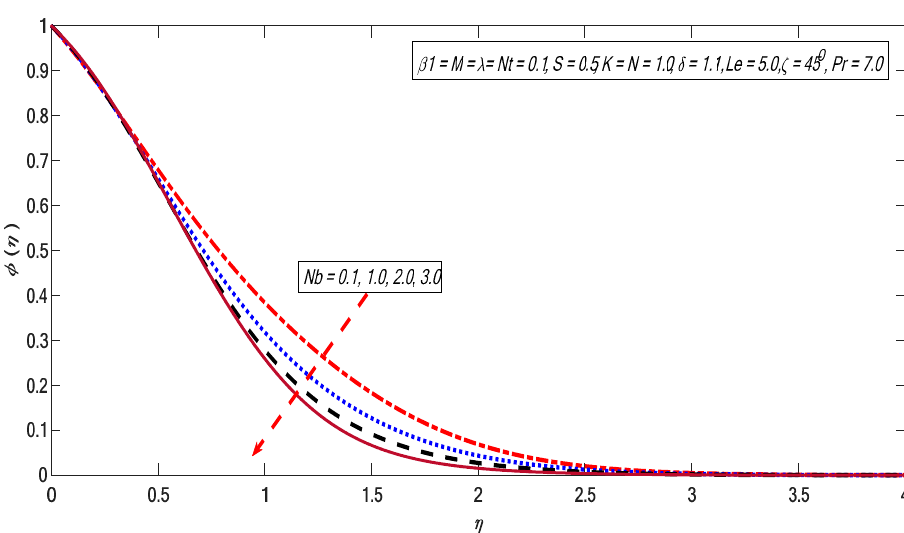
Figure 16. Variations in concentration profile for several values of 𝑁𝑏 .